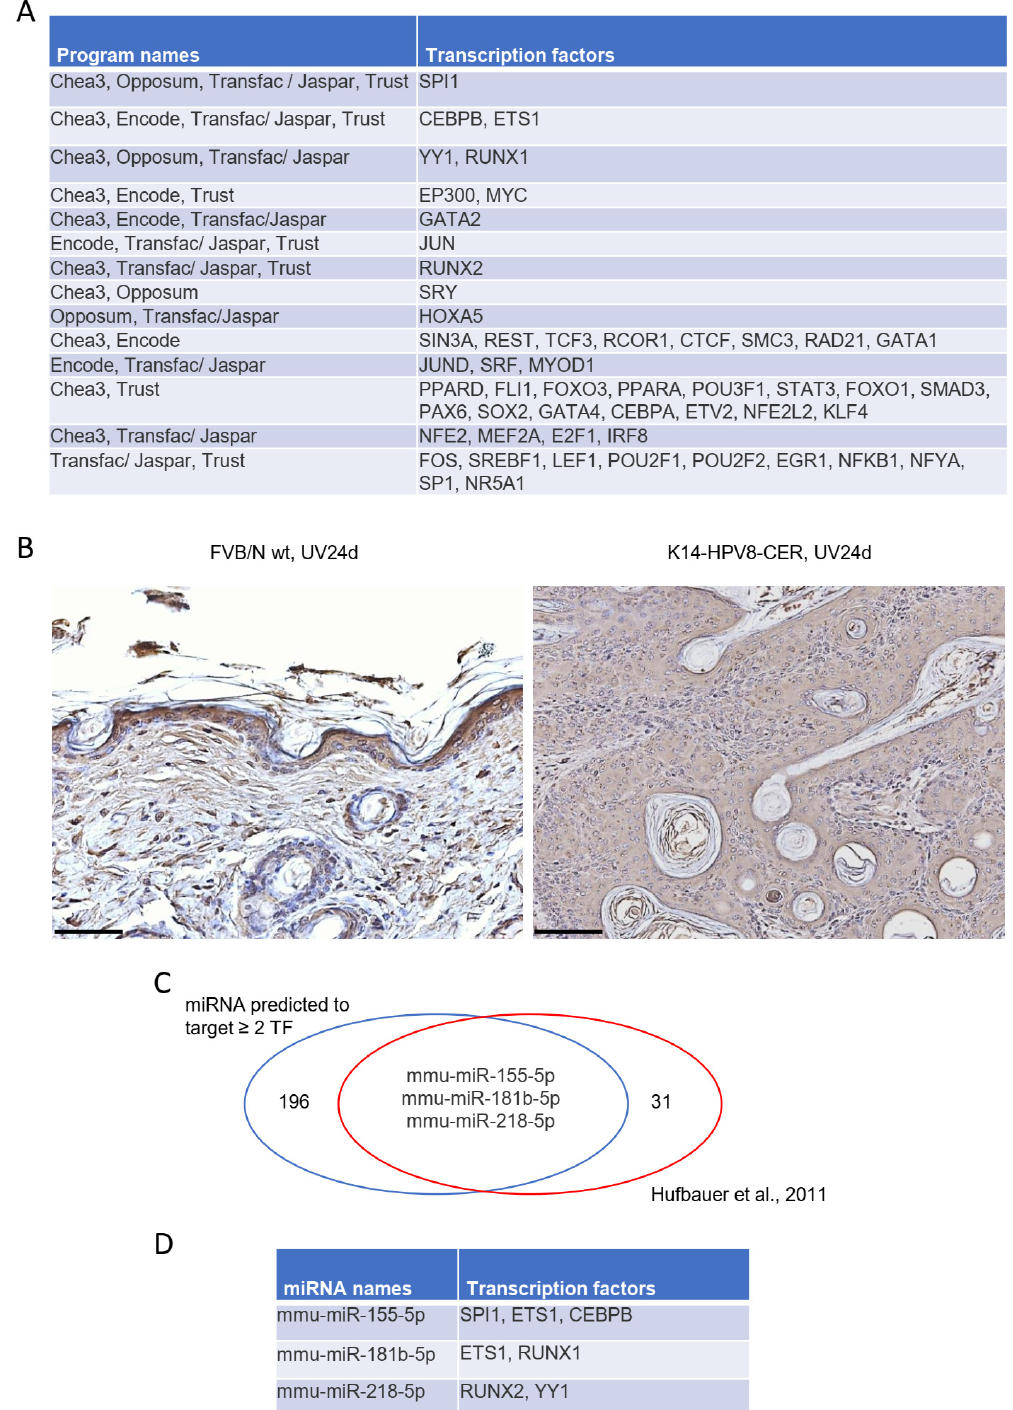
Figure 4. Identified potential transcription factors (TFs) for regulation of 23 DEGs. TFs prediction was performed using the online tools Chea3, Encode, Opposum, Transfac/Jasper and Trust. ( A ) List of TFs predicted by at least three different programs. ( B ) Representative YY1 staining of FVB/N wild-type skin (scale bar: 50 µ m) and a skin tumour of a K14-HPV8-CER mouse (scale bar: 100 µ m) taken 24 days post UV treatment. ( C ) Venn plot of miRNAs predicted to target ≥ 2 TFs and miRNAs previously shown to be deregulated in skin tumours of K14-HPV8-CER mice [15]. Analysis led to the identification of three miRNAs, namely mmu-miR-155-5p, mmu-miR-181b-5p and mmu-miR-218-5p to be upstream regulators. ( D ) The TFs as targets of these miRNAs are